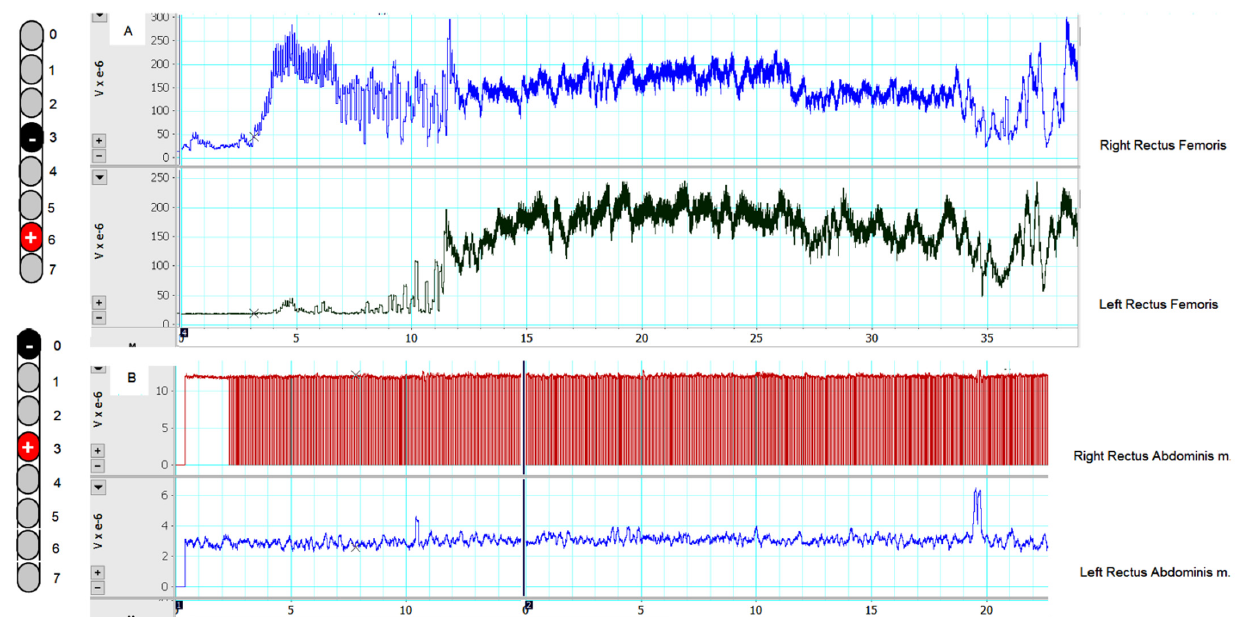
extensors and the right mGM muscle (because of the close proximity to the right lead), with noted firing of the left m GM when the amplitude of the current was adjusted to 5 volts (Figure 6).